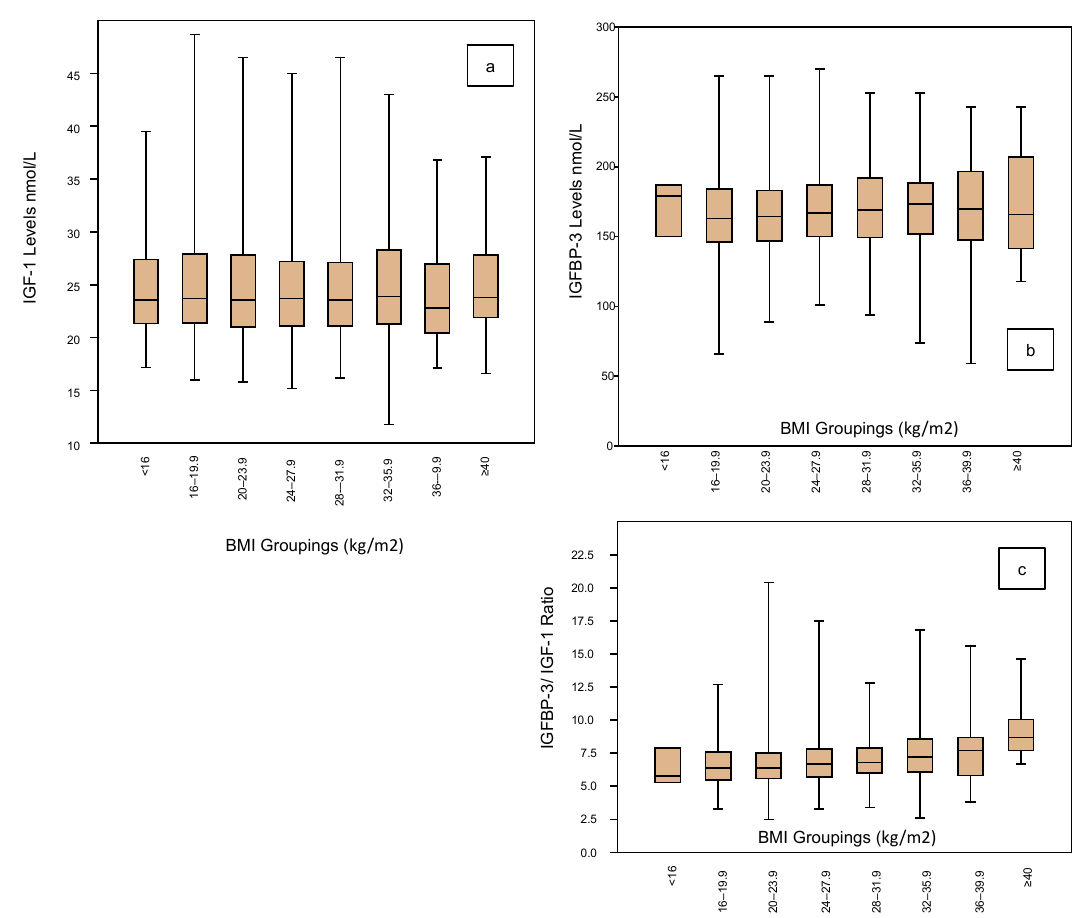
Figure 4. Shows the IGF-1 profile according to the BMI ratings (grouped by 4 units) of the 1633 women who completed an Assessment Cycle prior to any ART treatments. There is no significant variation in the IGF-1 mean levels across the BMI spectrum from < 16 (comprising 3 cases only) to > 40 (comprising 17 cases only) ( a ). Neither is there any significant change in IGFBP-3 levels across the BMI ranges (box plots; ( b )). These unchanged mean levels therefore translate to a stable IGFBP-3 / IGF-1 ratio across the BMI spectrum ( c ). Table 3. Summary statistics are shown for the 1633 women stratified according to BMI groups and depicted in Figure 4. Applying the same statistical profile depicted in Table 1, now sub-categorized for the 8 BMI groups with respect to IGF-1 levels, IGFBP-3 levels and the IGFBP-3/IGF-1 ratio. Noting there are only small numbers of cases in the lowest and highest BMI groups, there are no significant differences in the mean levels, the medians or the inter-quartile ranges across the BMI spectrum.